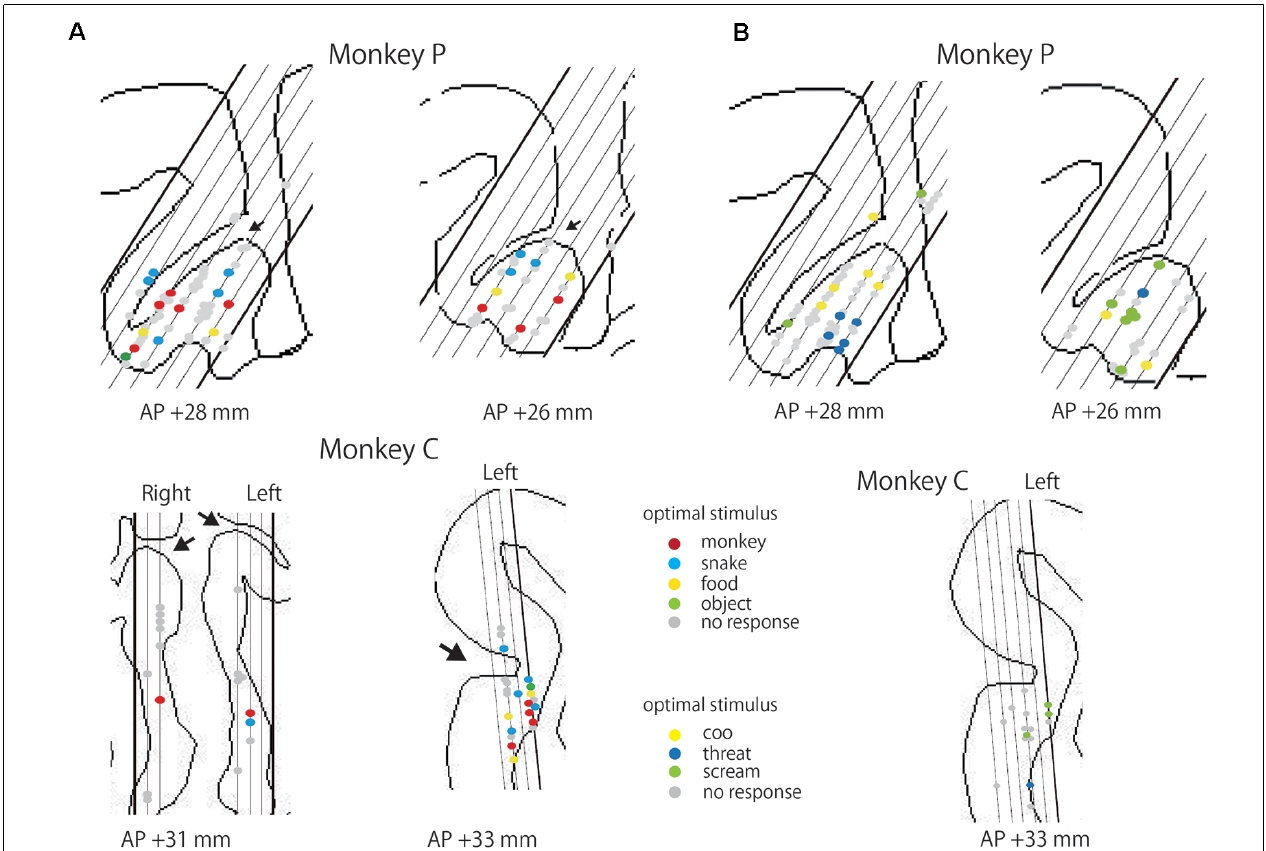
FIGURE 6 | Locations of responsive neurons in the ACC. (A) Locations of the neurons responsive to photo stimuli from each monkey. Red, blue, yellow, and green dots indicate the neurons exhibiting the maximal response to Monkeyface , Snake, Food , and Object , respectively. Gray dots represent neurons that showed no significant response to any photo stimuli. An arrow indicates the cingulate sulcus. Each slanting line corresponds to each penetration in the recording chamber. (B) Locations of the neurons responsive to video stimuli from each monkey. Yellow, blue, and green dots indicate the neurons showing the maximal response to Coo , Threat , and Scream of conspecifics, respectively. Gray dots indicate neurons that showed no significant response to any video